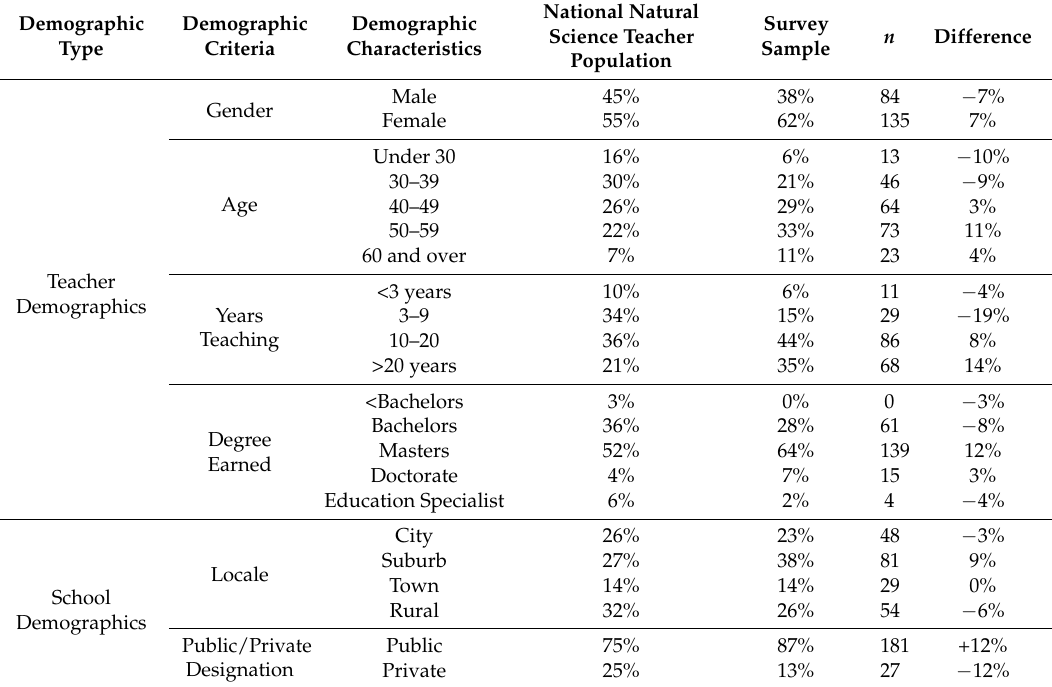
Table 1. Comparison of U.S. teacher and school demographics to survey